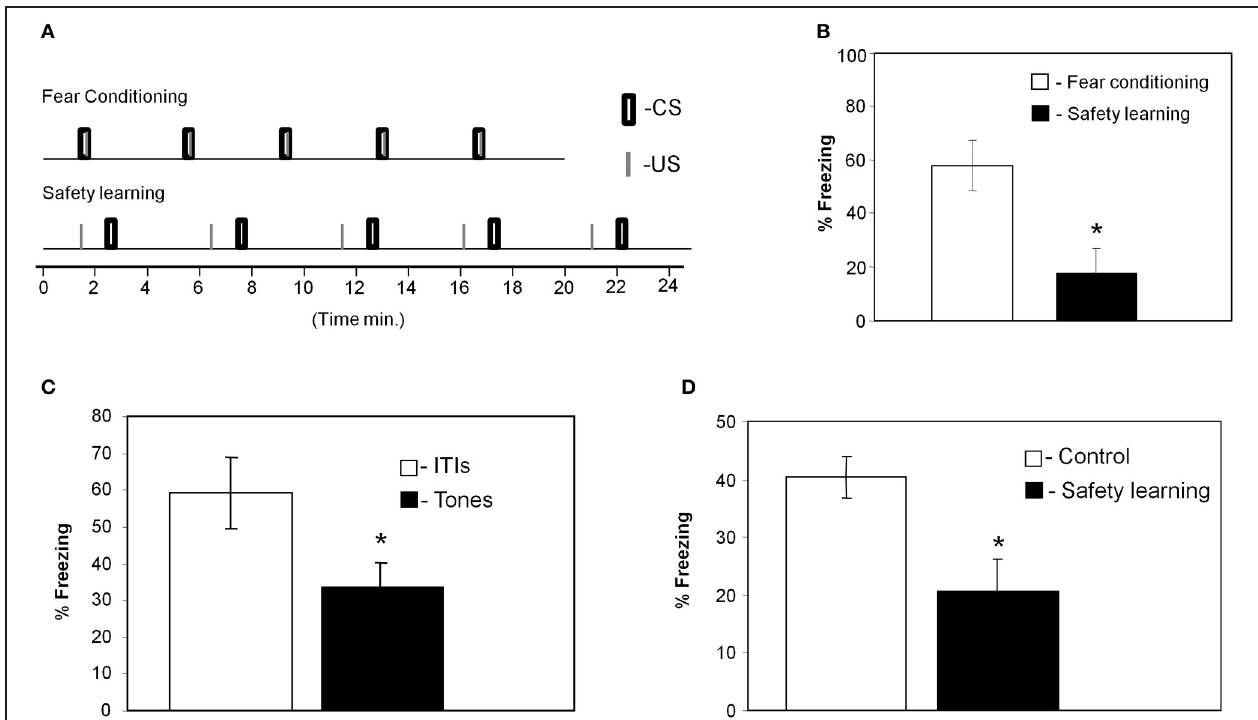
FIGURE 1 | Paired presentation of tone and shock leads to fear conditioning whereas unpaired presentation to safety learning. (A) Training protocols for fear conditioning and safety learning indicating the exact timing of tones and footshocks presentations. (B) Rats that received paired presentation of tone and shock froze significantly more during test tones when compared to animals that received unpaired presentation ( ∗ p < 0 . 01) when tested 24h after training indicating that they were fear conditioned to the tone CS. (C) In summation test animals that received tone and shock presentation in an unpaired manner froze significantly more during the ITIs than during the tone